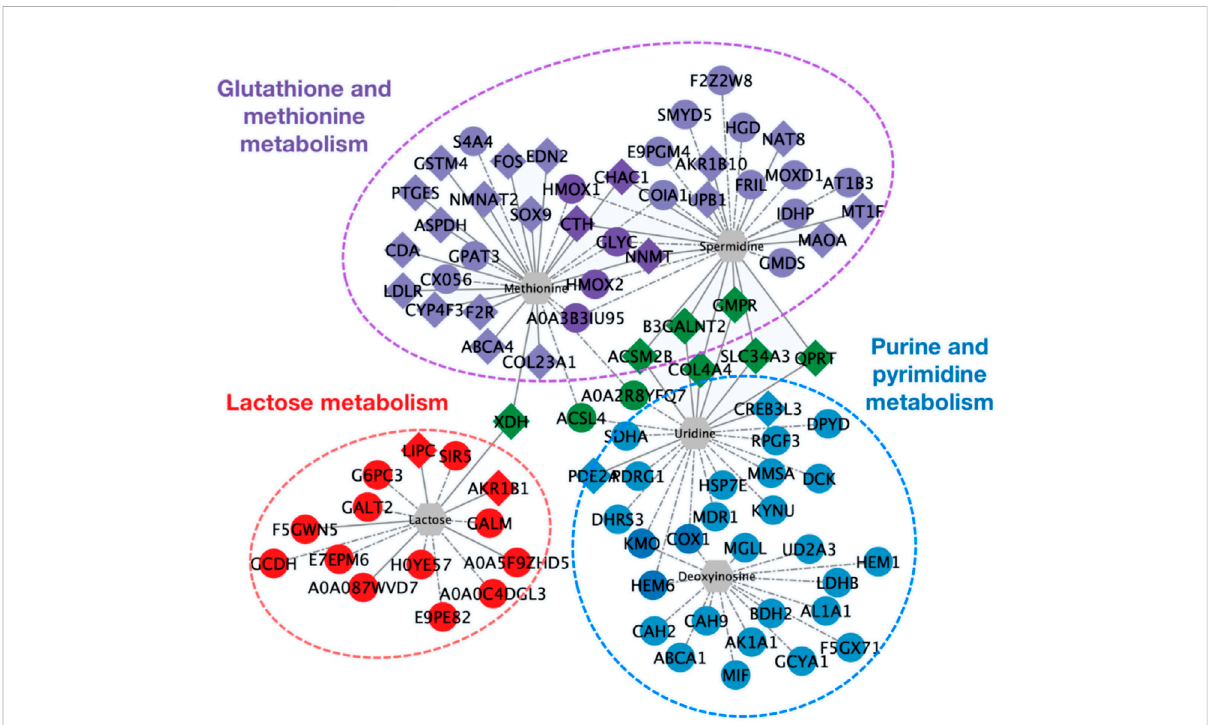
FIGURE 6 Network diagram of the interaction among differential expressed genes, proteins, and differential metabolites. Diamonds represent differential genes; circlesrepresent differential proteins;hexagonsrepresent differentialmetabolites.Realizationsrepresent theinteractionbetween differential expressed genes and differential metabolites; dashed lines represent the interaction between differential proteins and differential metabolites. Red indicatesgenesandproteinsinvolvedinlactosemetabolism.Blueindicatespurineandpyrimidinemetabolism.Purpleindicatesglutathioneand methionine metabolism. Green indicates differential expressed genes and proteins involved in the regulation of more than 2 types of